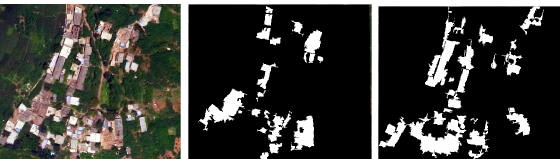
Figure 3. The original map (left) and the truth ground map of collapsed building (middle) and un-collapsed building(right)